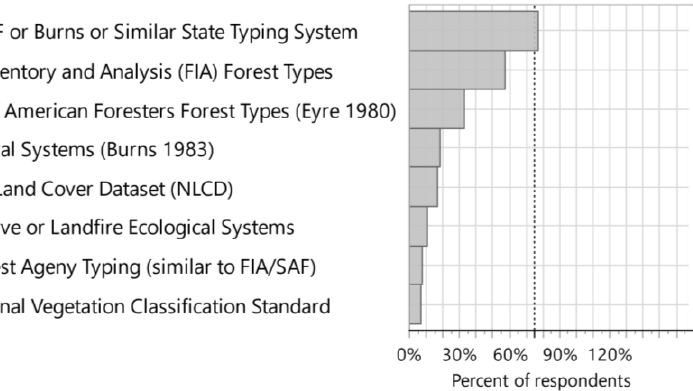
Figure 5. Common forest classification/typing systems used by forest managers. Dotted line represents 75% of survey respondents.